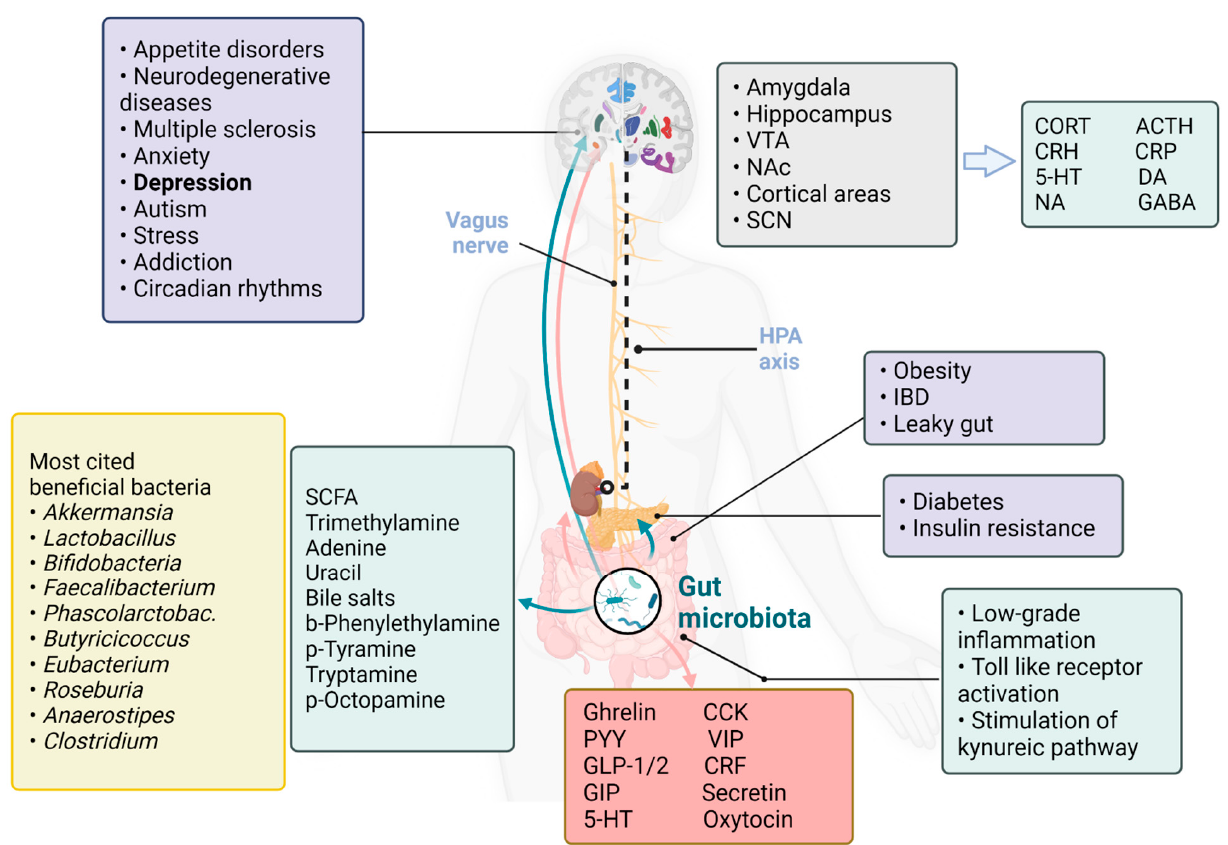
Figure 1. Summary of the crosstalk between the microbiome, gut, brain and gut hormones. SCFA: short-chain fat acids; PYY: peptide YY; GLP-1/2: glucagon-like peptide 1 and 2; GIP: glucose-dependent insulinotropic polypeptide; 5-HT: serotonin; CCK: cholecystokinin; VIP: vasoactive intestinal polypeptide; CRF: corticotropin-releasing factor; VTA: ventral tegmental area; NAc: nucleus accumbens; SCN: suprachiasmatic nucleus; CORT: cortisol; CRH: corticotropin-releasing hormone; NA: noradrenaline; ACTH: adrenocorticotropic hormone; CRP: C-reactive protein; DA: dopamine; GABA: gamma-aminobutyric acid; HPA axis: hypothalamic-pituitary-adrenal axis.